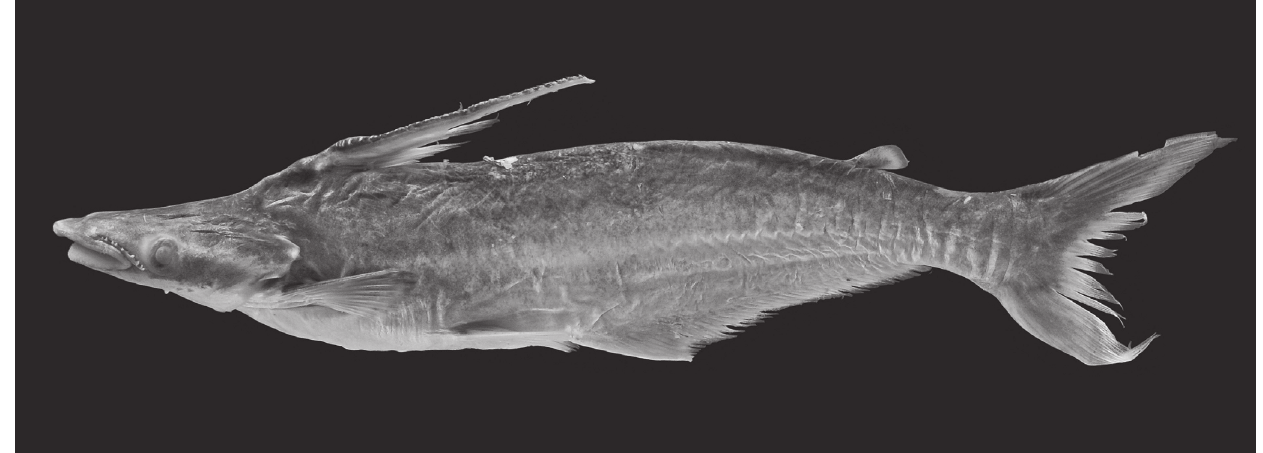
Fig. 3. Ageneiosus uranophthalmus , paratype, INPA 22723, 192.5 mm SL, nuptial male in lateral view. characters of A . uranophthalmus are unique within the auchenipterids. The intrageneric biodiversity and relationships of Ageneiosus are still under investigation.